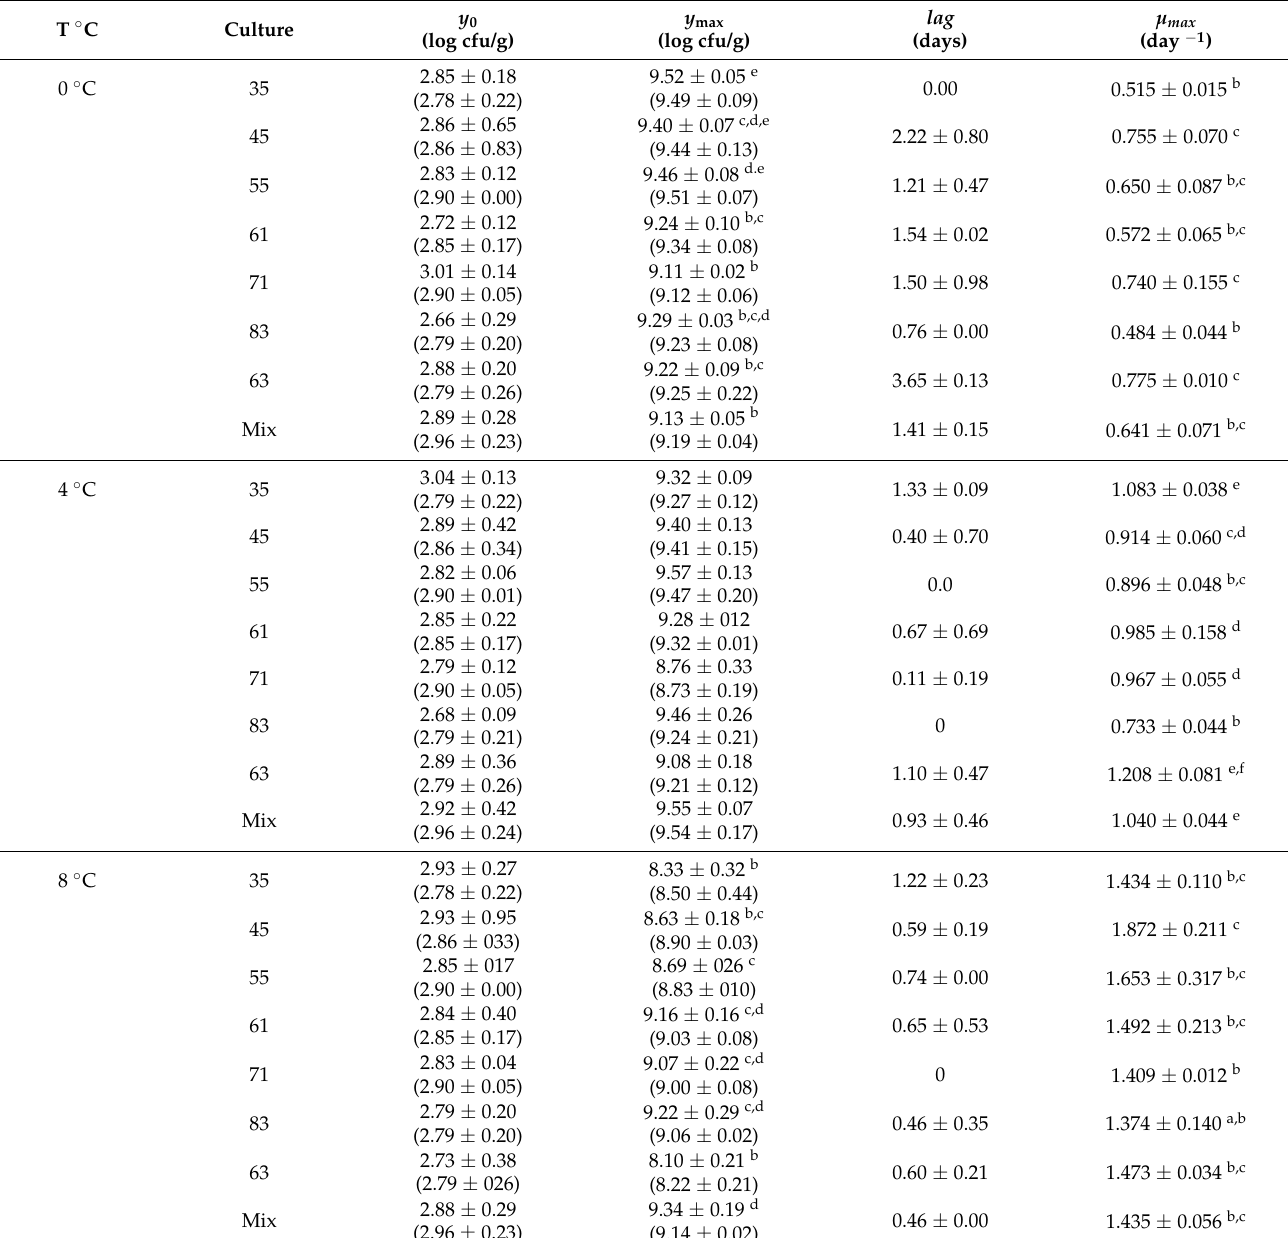
Table 2. Predicted, initial ( y 0 ), final population ( y max ), lag phase duration ( lag ) and maximum specific growth rates ( µ max ) of Pseudomonas strains inoculated in fish juice agar model substrates stored at 0, 4 and 8 ◦ C, as estimated by Baranyi equation (Baranyi and Roberts, 1994). The values in parentheses are the observed initial and maximum population